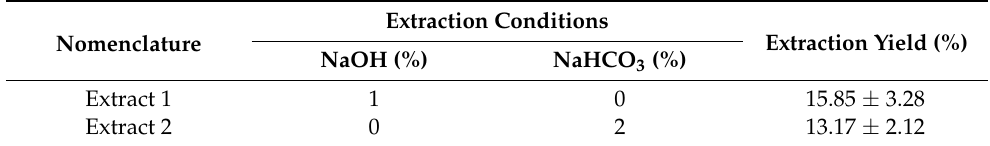
Table 2. Yield for different extraction